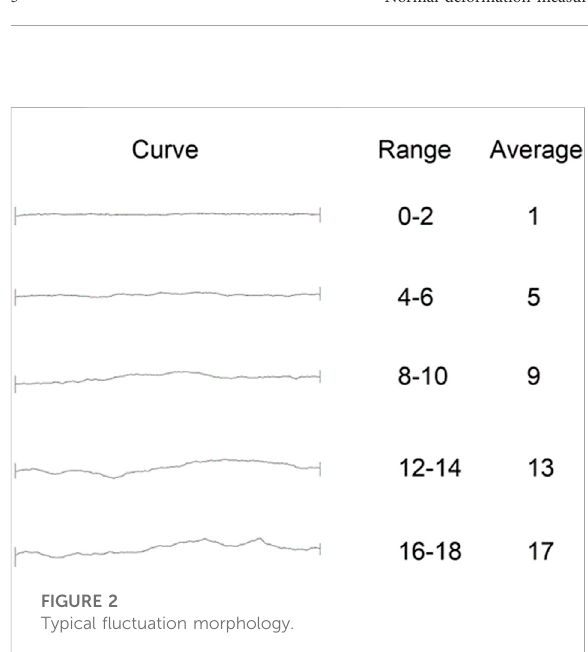
FIGURE 2 Typical fl uctuation